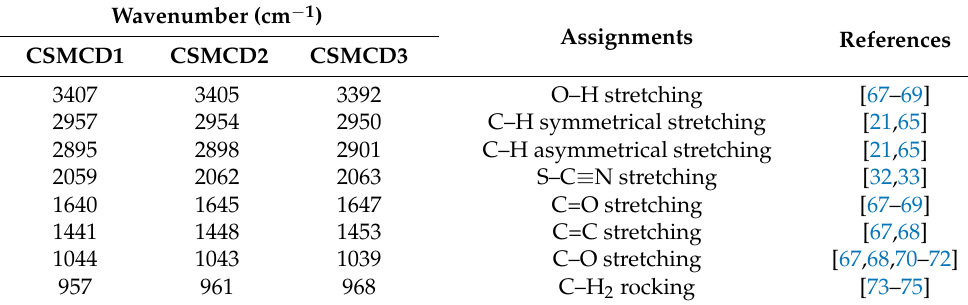
Table 3. Vibrational assignments of FTIR spectra for the